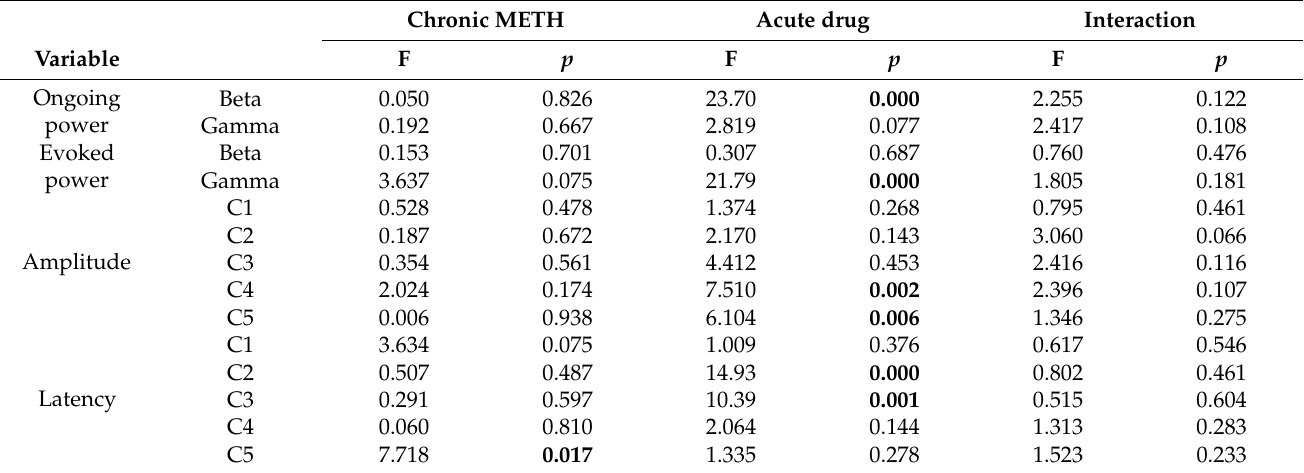
Table 1. Results of ANOVA for electrophysiological